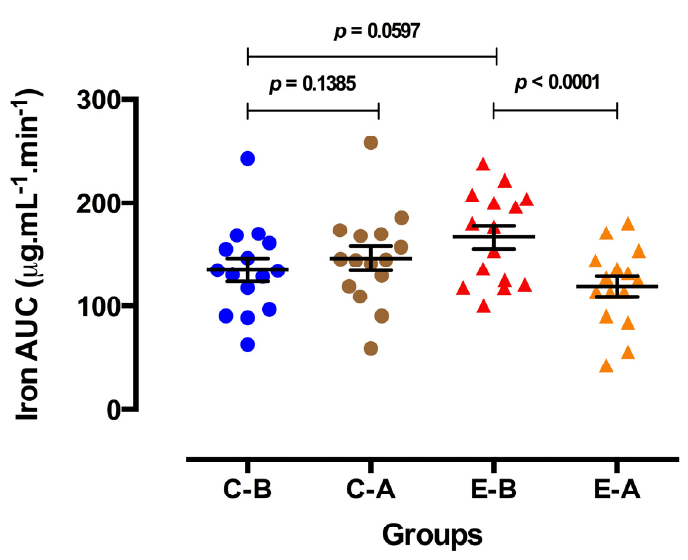
Figure 4. Area under the iron curves in the control and experimental groups before and after 3 mo of placebo or oral zinc administration. C-B = Control-Before, C-A = Control-After, E-B = Experimental-Before, E-A = Experimental-After. Concentrations are expressed as the mean ± SEM. p values were calculated using paired and unpaired Student’s t tests. All comparisons were considered to be statistically significant at the 5% level ( p <